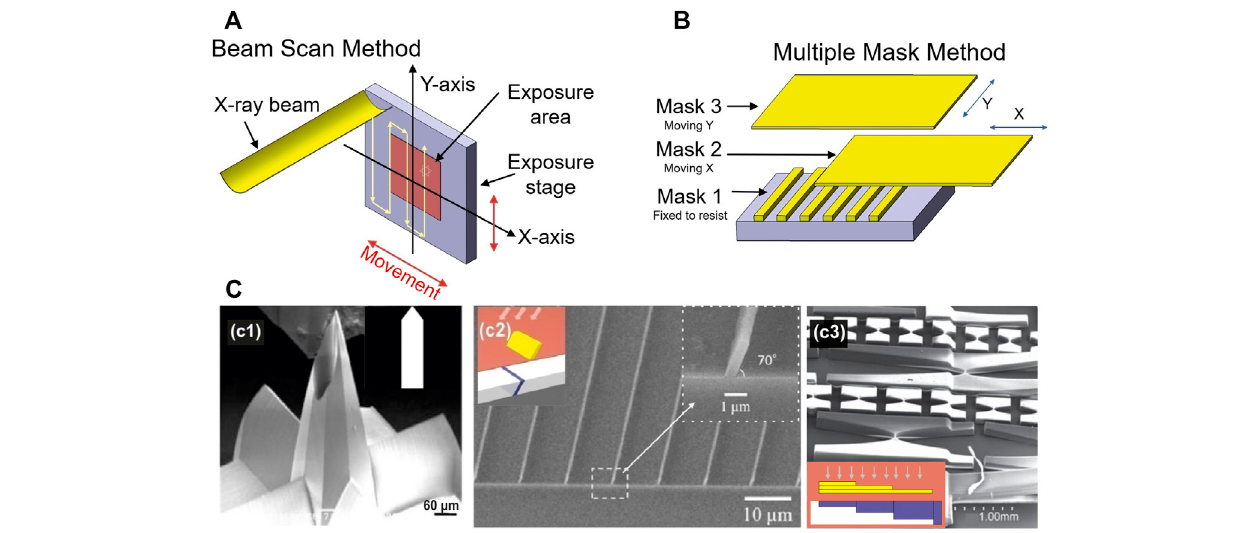
FIGURE 1 | (A) Scheme of the beam scan method. The exposure stage (assembly of mask and sample) is moved with respect to the beam during exposure. (B) Scheme of the multiple mask lithography, where superimposed masks are moved while irradiating. The idea comes from Moser et al. (2012). (C) Examples of 3D structures obtained with XRL. (c1) 3D Microneedle fabricated using three aligned exposures of which two are dynamic by moving an obelisk-shaped absorber mask (shown in the inset) fi rst in one direction, and then at 90 ° on the same plane. In this way, the pyramid needle is obtained. A third static exposure is performed to obtainthe needlehole.Adapted fromWang et al.(2021) (c2) Oblique submicron structures ofa10- μ mperiod at 20 ° obtained withaslanted mask and exposure(shown in the inset). Adapted from Kim et al. (2021). (c3) Step-like microstructures with height 250 and 150 µm obtained by changing the absorber thickness of the mask. Adapted from Nazmov et al. (2020) with permission of AIP